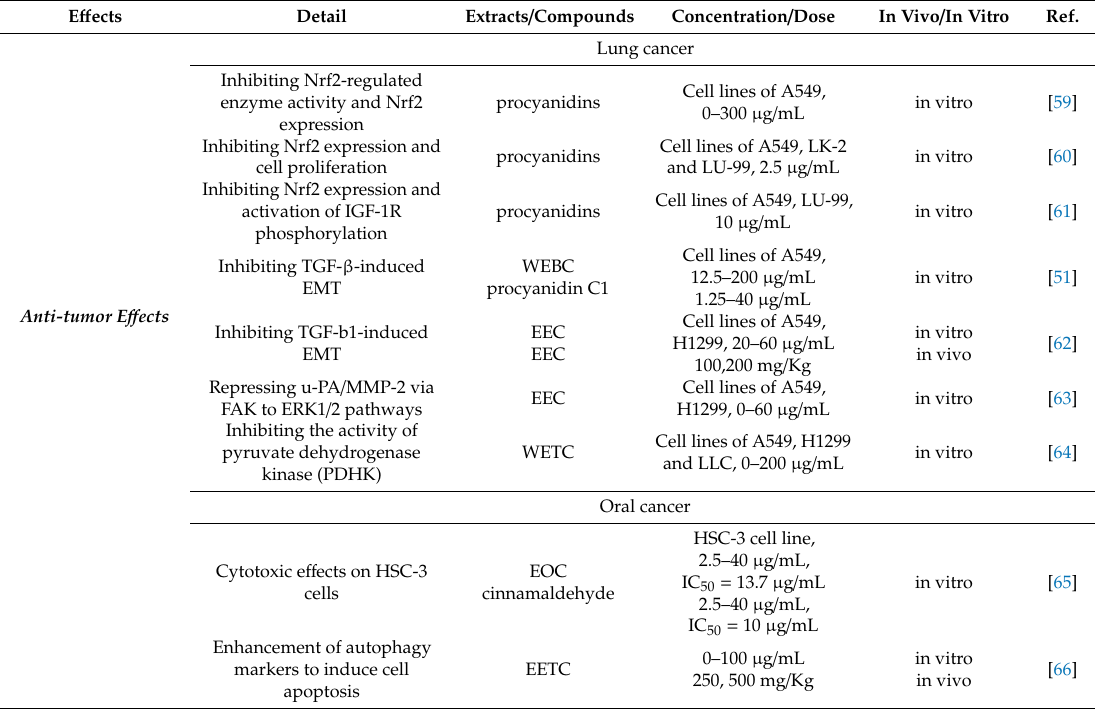
Table 3. Pharmacological e ff ects of C.